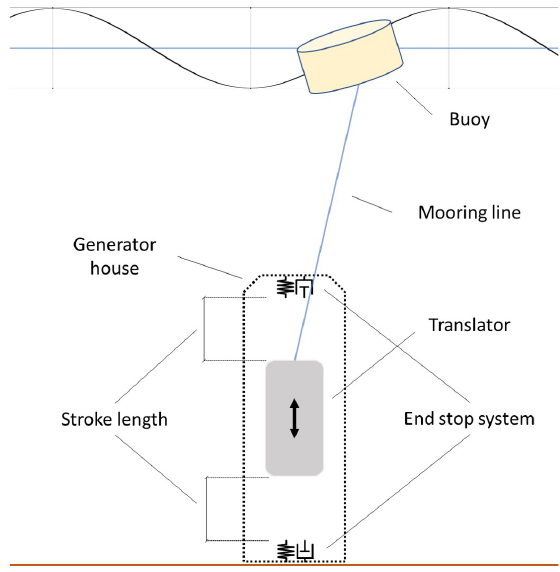
Fig. 1. Outline of the modelled UU WEC system. Please note that the figure is not according to scale.